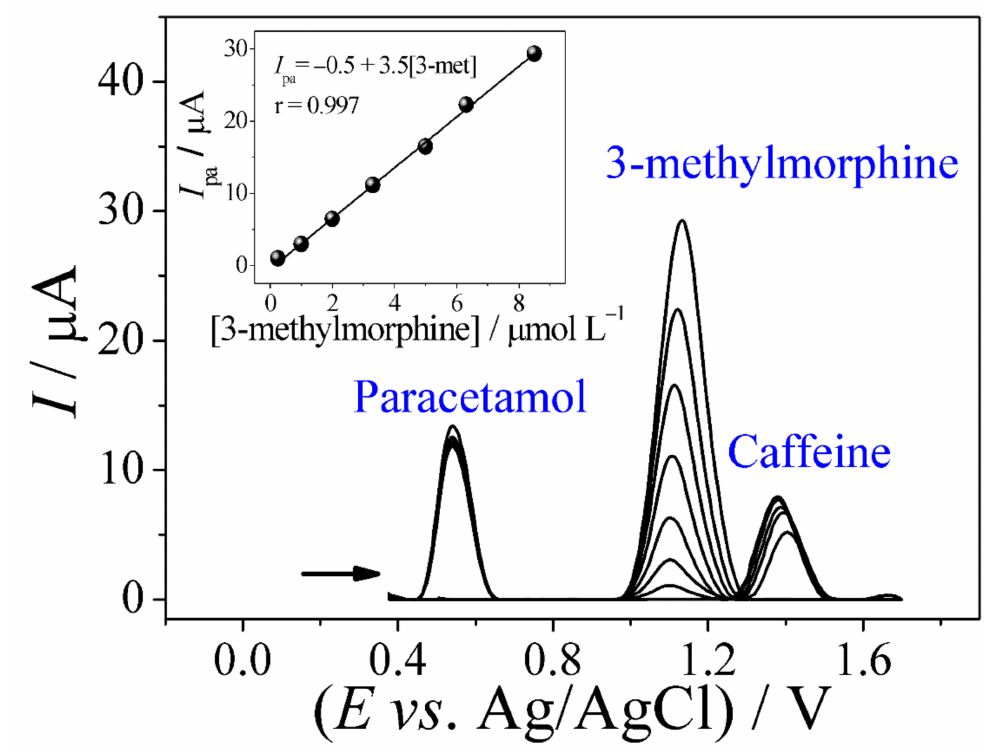
Figure 8. SW voltammograms obtained from the application of Bi-rGO-CTS/GCE for the determina- tion of 3-methylmorphine in the presence of paracetamol and caffeine (at fixed concentration). Inset: Corresponding calibration plots related to 3-methylmorphine